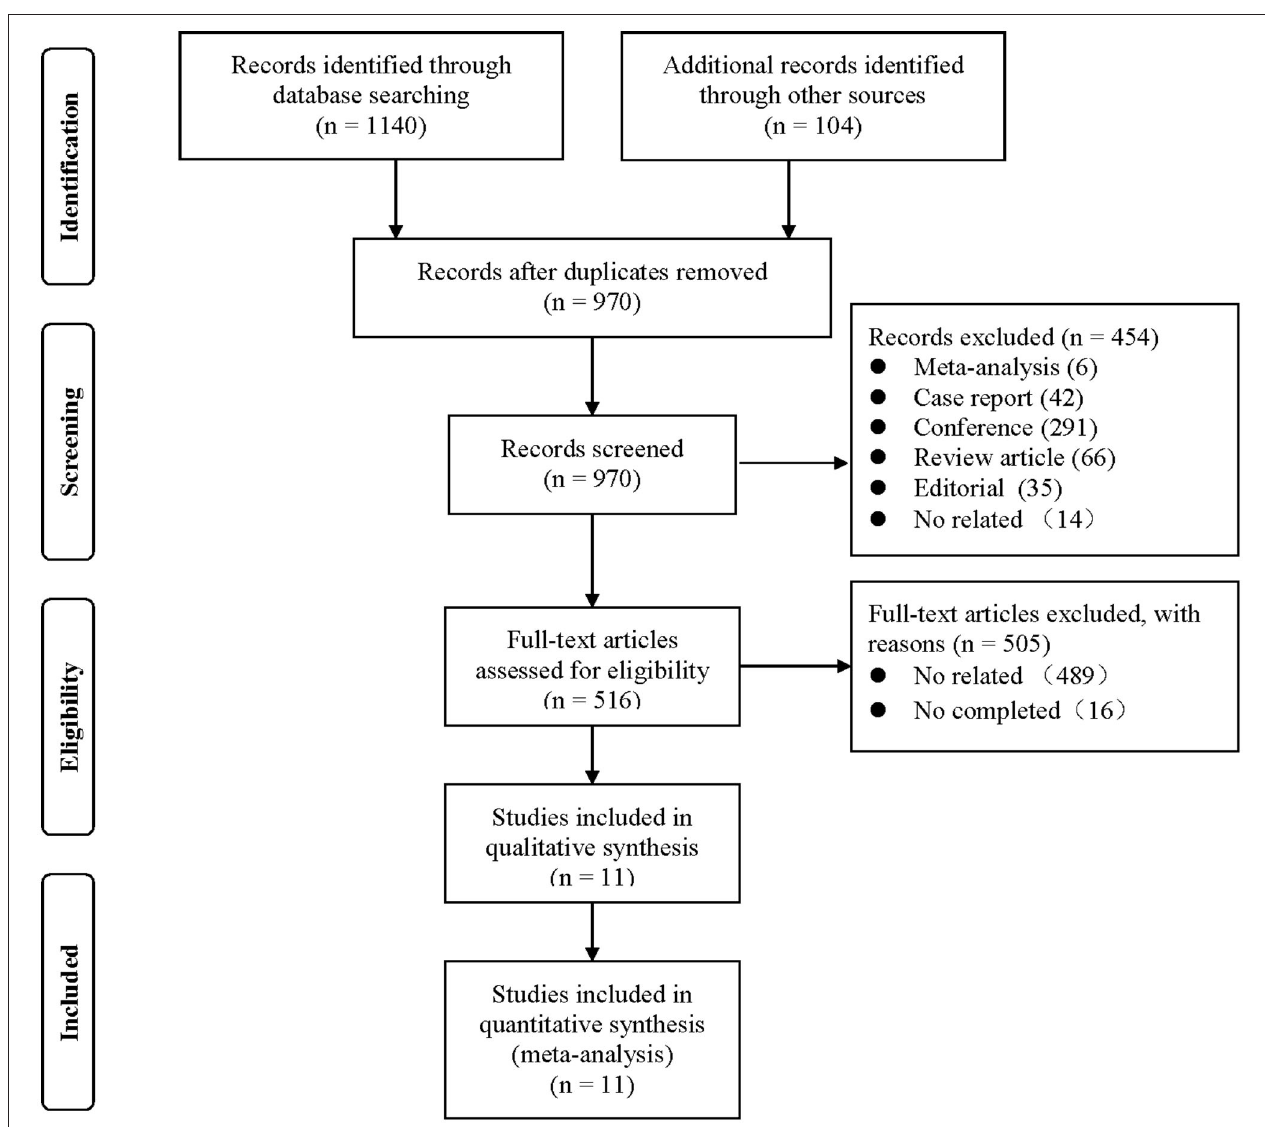
FIGURE 1 | Flow diagram for study selection.